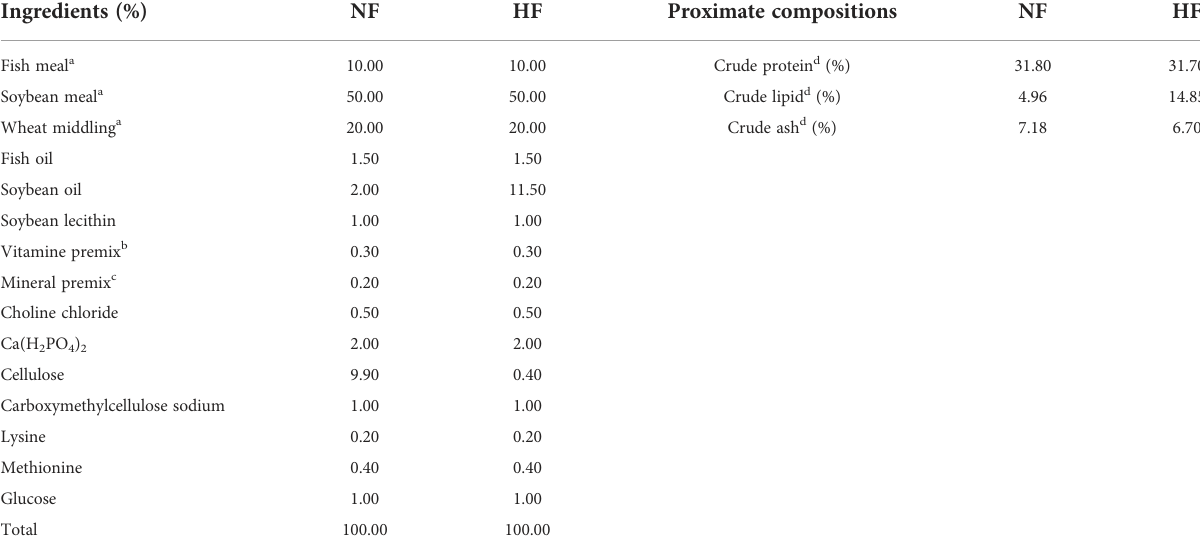
TABLE 1 Formulation and proximate composition of experimental diets (% dry matter). Ingredients